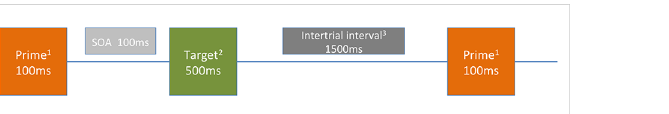
Fig 1. Presentation times of the priming task elements. 1 Primes were verbal stimuli (positive, negative, neutral, or illness-related) or facial stimuli (angry, happy, or neutral); 2 Targets were verbal stimuli (positive, negative, or illness-related) or facial stimuli (angry or happy); 3 During the intertrial interval a fixation cross was presented; SOA = stimulus onset